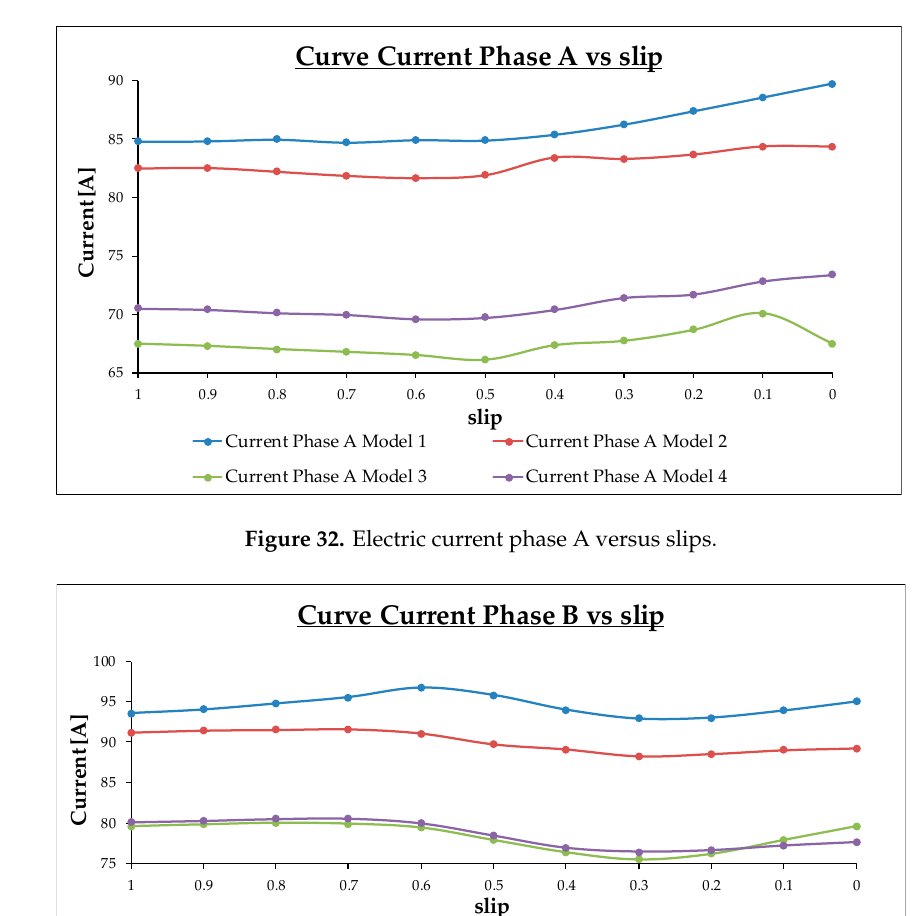
Figure 34. Electric current phase C versus slips. For each model, the relationship between the electric currents followed Equation (17). Besides, model 3 was the configuration that presented a low electric current consumed by each phase across the range of velocities. So, with a slip of 0.5, phase A and phase C in model 3 only consumed 66.14 and 70.60 A, respectively. Phase B reached its minimum value with a slip value of 0.3 (around to 75.55 A). If we compare the obtained results considering the whole range of slips from Figures 30–34, we have available a great amount of information about the convenience to include the proposed changes